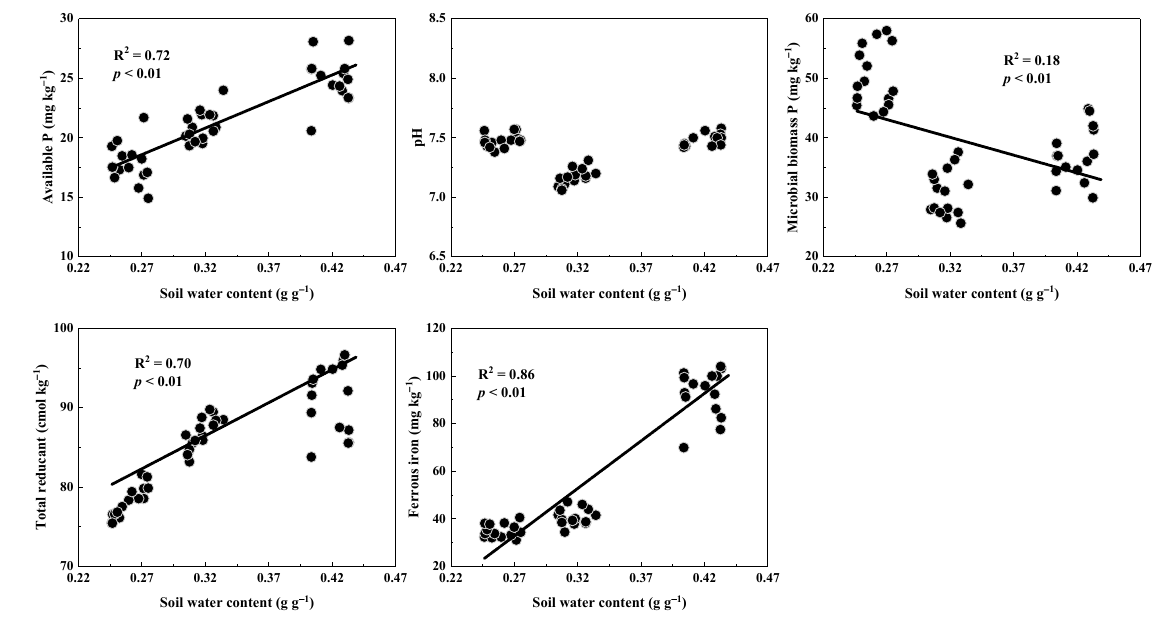
Figure 7. Relationships between soil water content and available P, pH, microbial biomass P, total reductant, and ferrous iron under alternate wetting and drying irrigation.